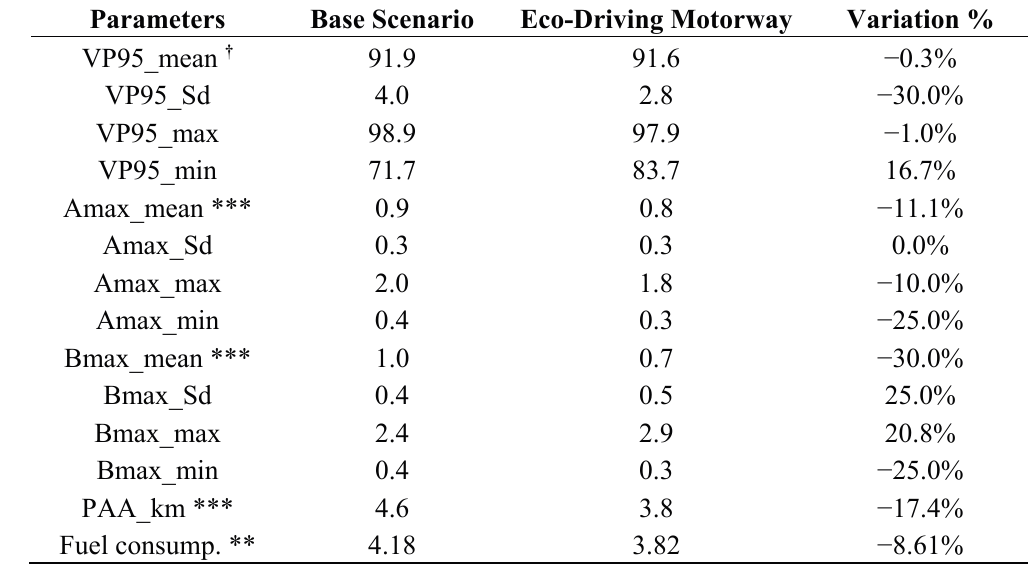
Table 6. Changes in vehicle trajectory variables produced by eco-driving behaviour in motorway